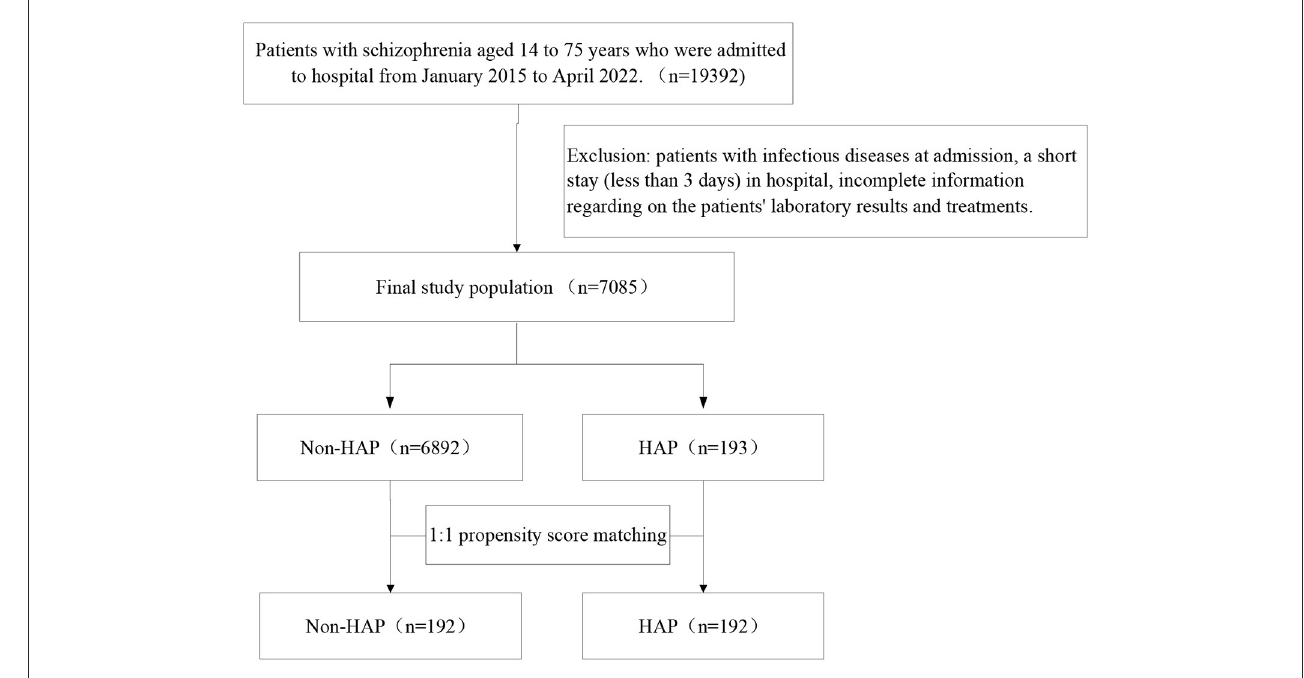
FIGURE1 The study design flow